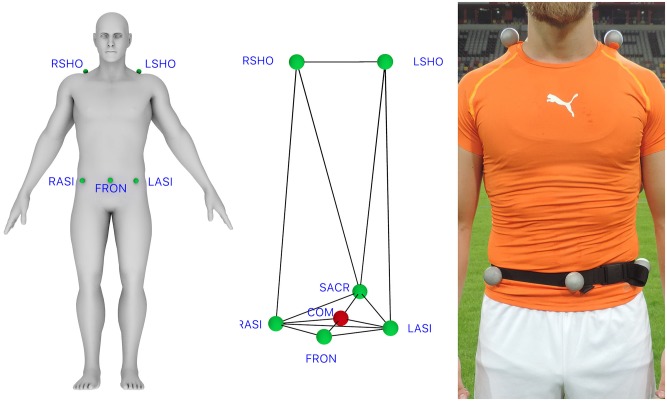
VICON marker positions on the human body (green), centre of mass COM (red).